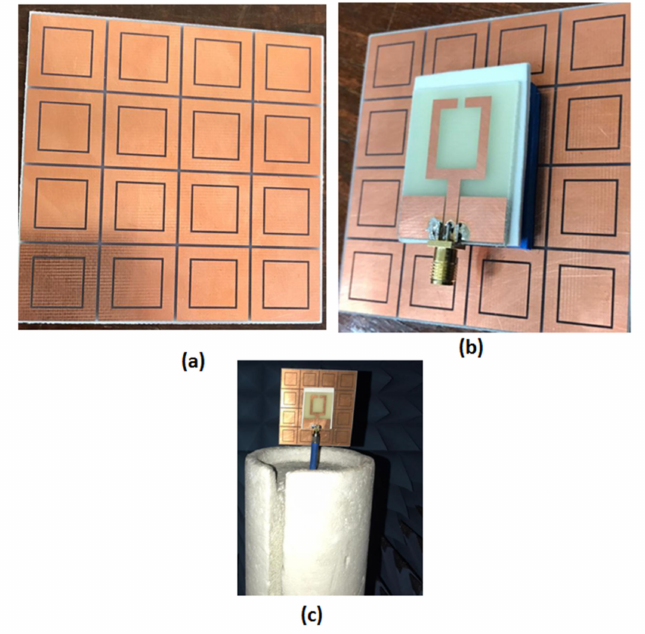
Figure 13. The layout of the proposed CPW monopole antenna. ( a ) Fabricated AMC prototype structure. ( b ) Fabricated prototype of antenna integrated with the AMC. ( c ) Radiation pattern measurement setup of the proposed antenna.